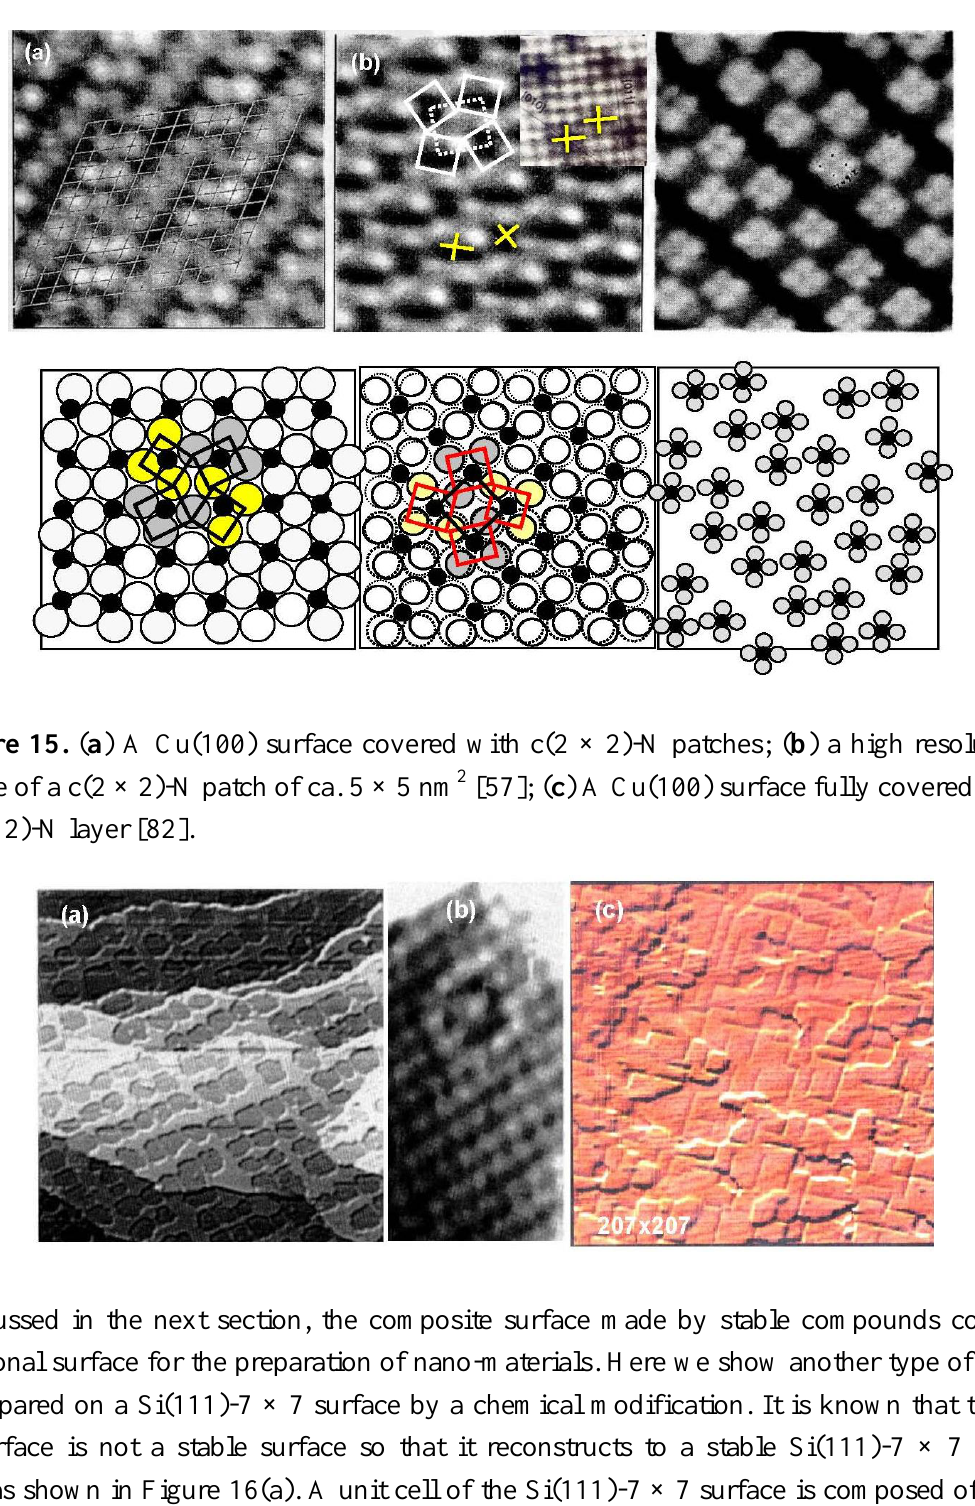
Figure 14. STM images of Ni-carbide formed on Ni(111), Ni(100) and Ni(110) surfaces [51,52] ; ( a ) (√39 × √39)-C/Ni(111); ( b ) (2 × 2)p4g-C/Ni(100). Inset image shows random segregation of Ni C molecules in an initial; ( c ) c(4 × 5)-C/Ni(110) surface. 4